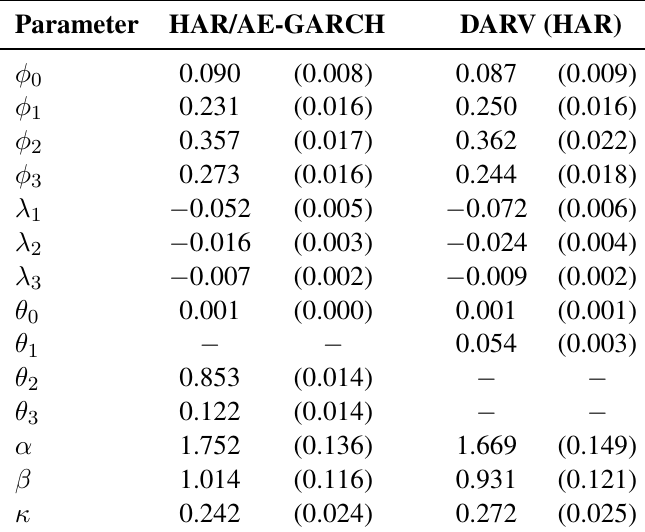
The table shows parameter estimates for different restrictions of the model: RV t = φ 0 + φ 1 RV t − 1 + φ 2 RV 5 ,t − 1 +